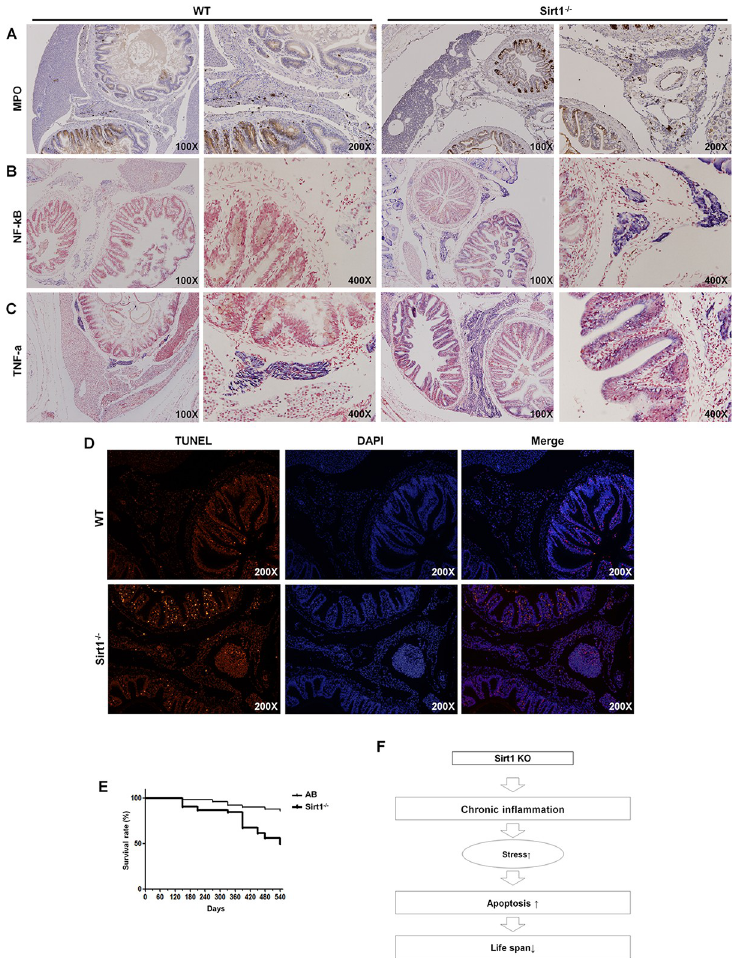
Fig 5. Expression of genes involved in inflammation and apoptosis induced by Sirt1 -knockout induced inflammation. All images were obtained from 12-month-old zebrafish. (A) Immunohistochemical staining for myeloperoxidase (MPO). (B) ISH for NF-kB and (C) TNF- α expression. (D) TUNEL assay with 18-month old zebrafish organ sections. Wildtype organ section with few apoptotic cells and Sirt1 -/- organ section with numerous apoptotic cells, as per the TUNEL assay. (E) Survival curves of wildtype and Sirt1 -/- mutant zebrafish. Kaplan–Meier analysis showed poor survival of Sirt1 -/- compared to the wildtype. (n = 100 zebrafish in each group). Survival curves lasted for 540 days (observation started when zebrafish were 3 months old.) and were statistically compared using the Log-Rank Test. (F) Schematic diagram of the major findings of this study. Sirt1 -/— induced chronic inflammation led to the activation of oxidative stress and apoptosis. The continuous repetition of these events reduced the lifespan of zebrafish.